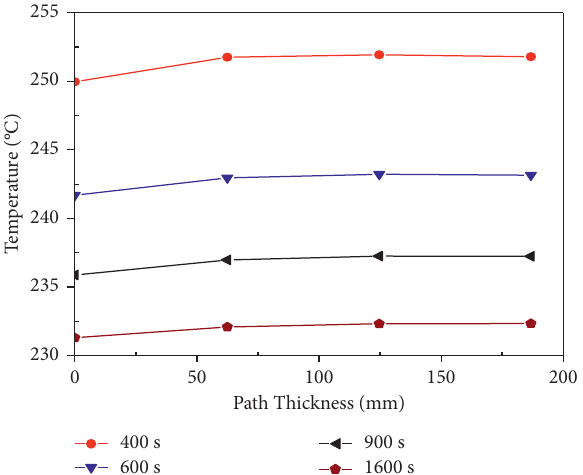
Figure 14: Axial stress distribution through inlet nozzle-inner RPV wall intersection (path) thickness at different